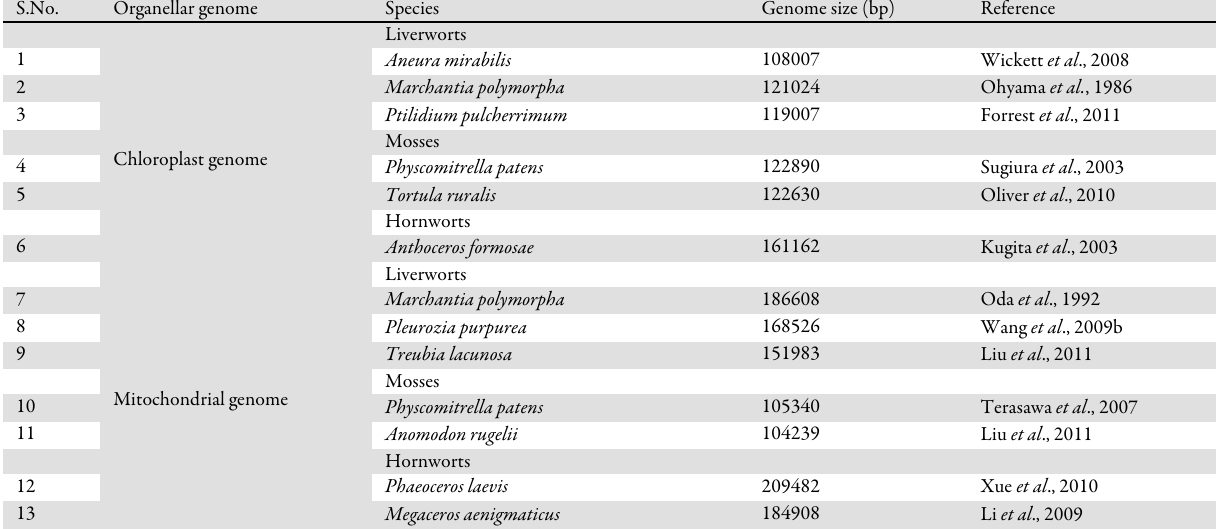
Table 1. The complete genome sequence of mitochondrial and chloroplast genomes of bryophytes submitted at NCBI S.No.